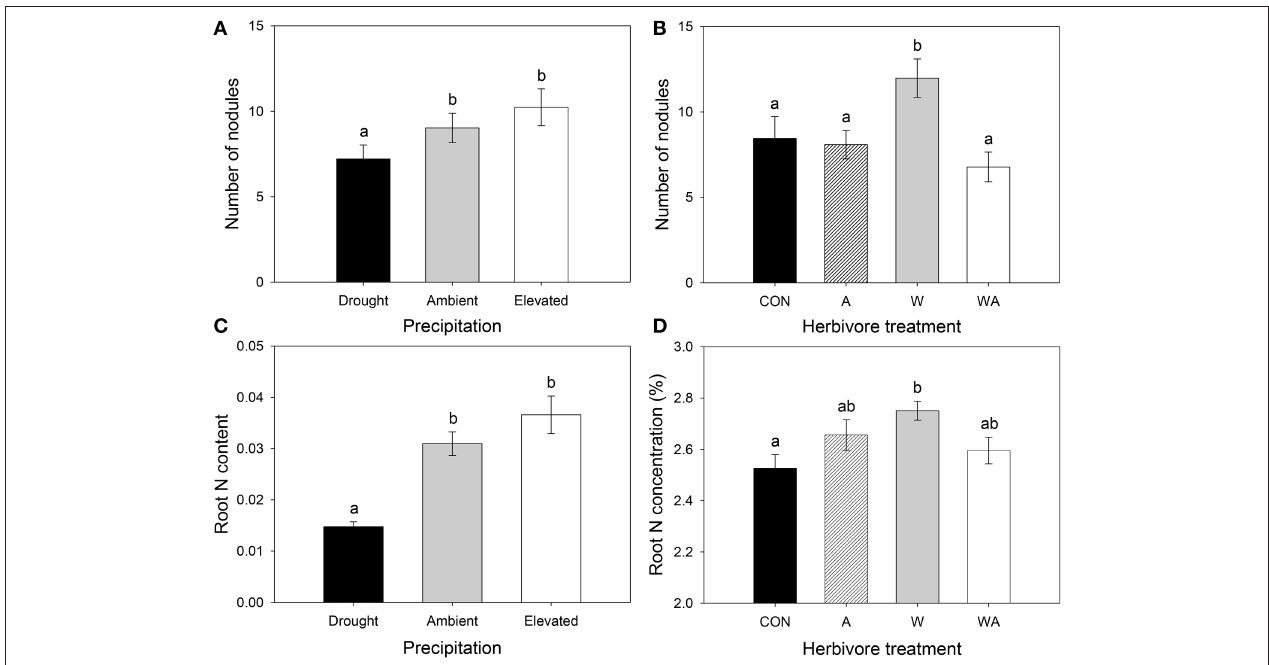
FIGURE 6 | The impacts of precipitation and herbivore treatment on lucerne nodulation (A,B) and the impacts of precipitation and herbivore treatment on root N content (C) and root N concentration (D), respectively. CON were the control plants (no insects), A had aphids alone, W had weevils alone, and WA had both insects. Mean values ( ± SE) are shown. Bars with the same letters were not significantly different ( P <